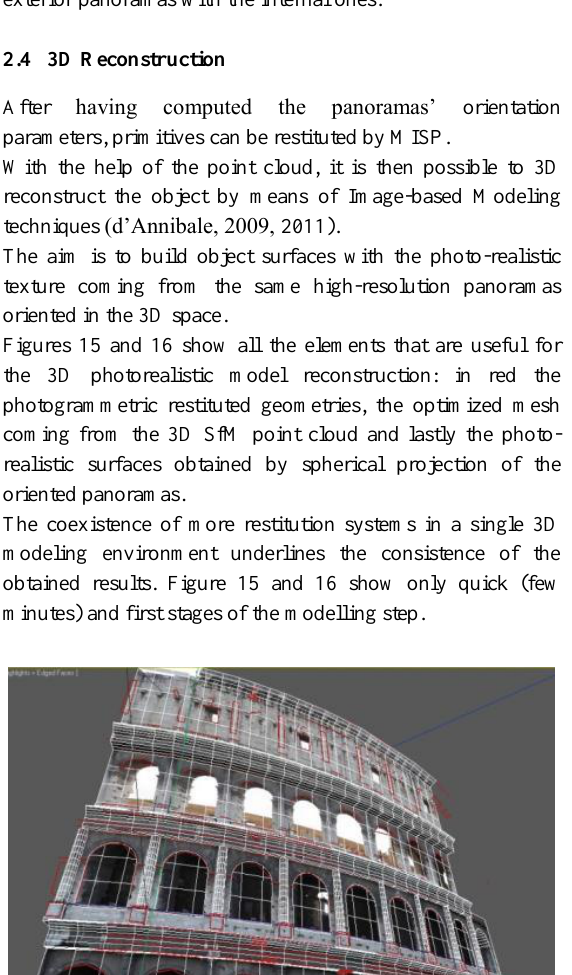
Figure 11. Six high resolution shots